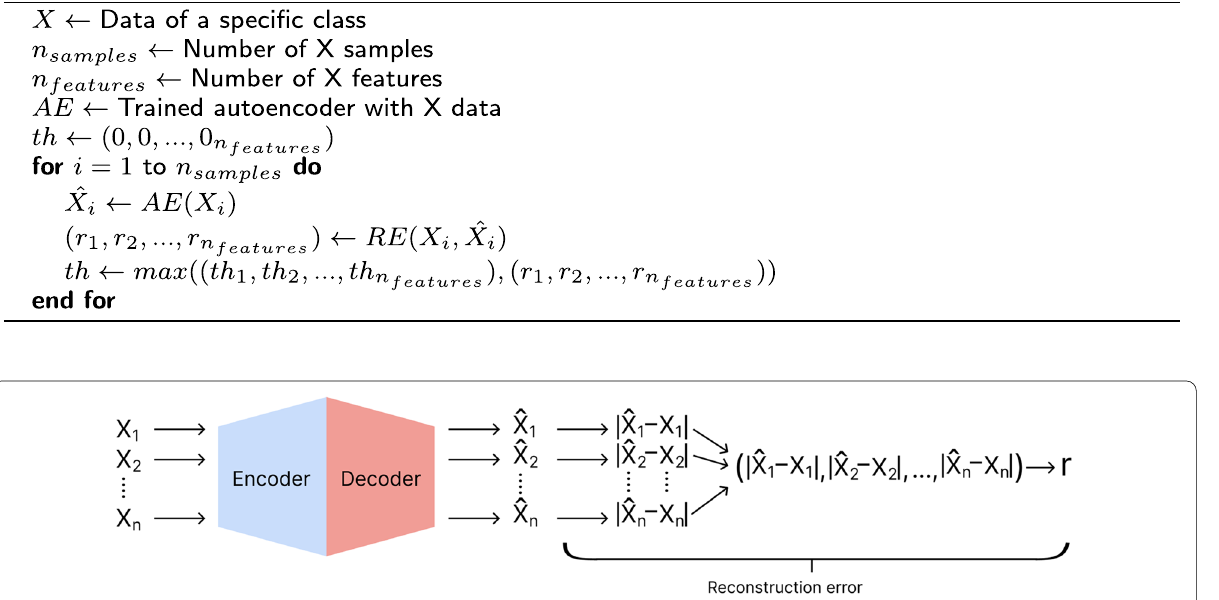
Fig. 5 The procedure of calculation RE in the proposed